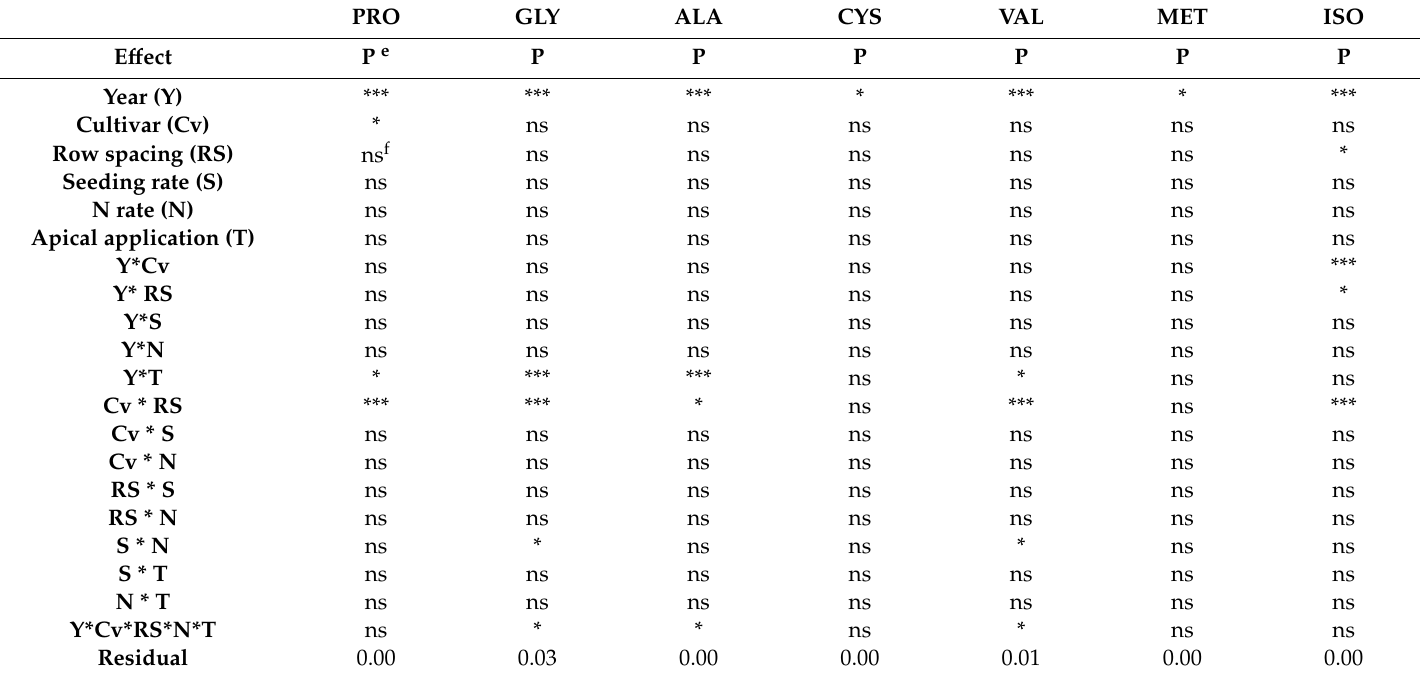
Table 3. Analysis of variance (P values) for the e ff ect of main e ff ects of year (Y), cultivar (Cv), row spacing (RS), seeding rate (S), nitrogen rate (N), apical application (T), and their interactions on seed amino acids proline (PRO), glycine (GLY), alanine (ALA), cystine (CYS), valine (VAL), methionine (MET), and iso-leucine (ISO) (%). The experiments were conducted in 2015 and